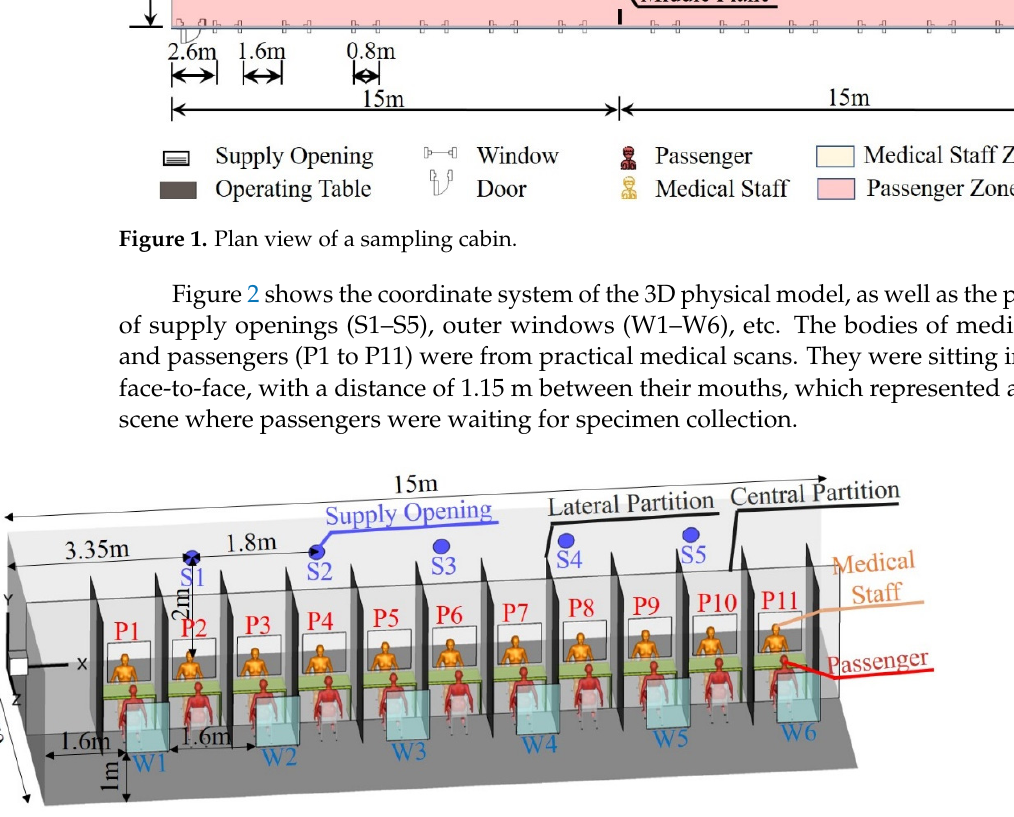
Figure 2. Three-dimensional physical model.